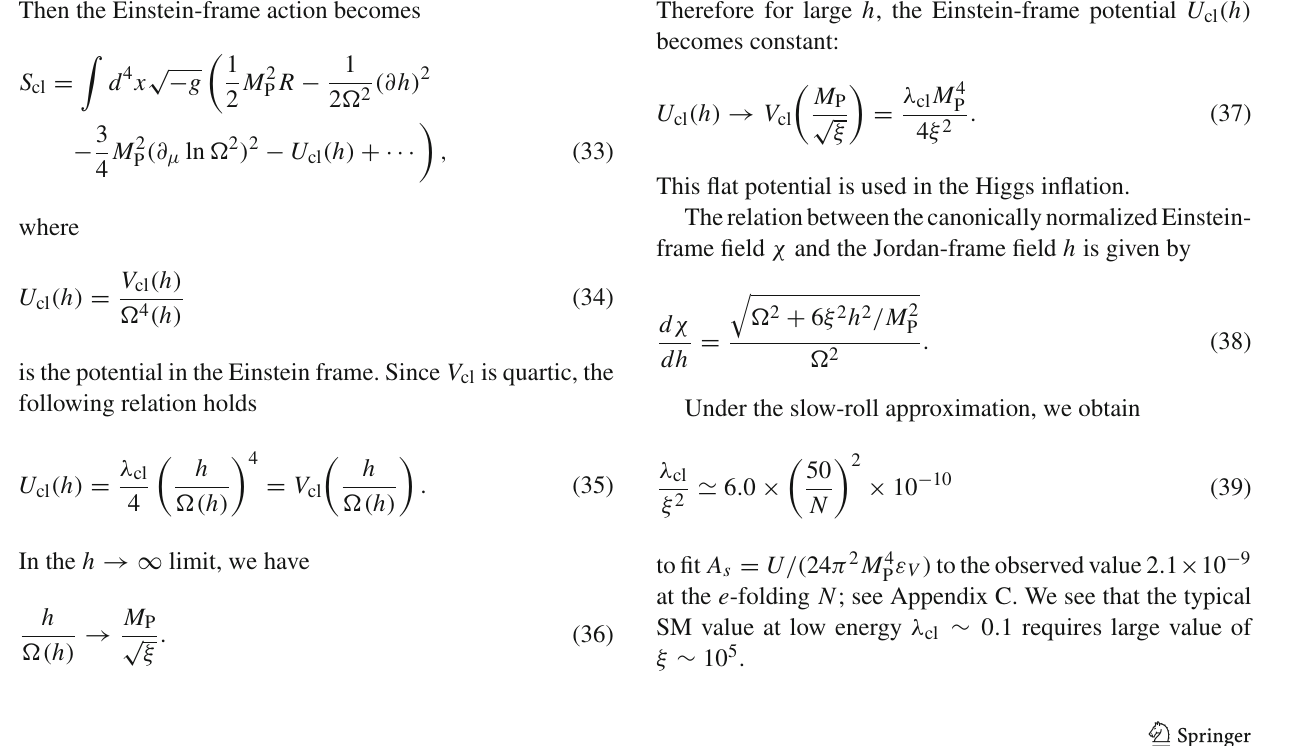
Fig. 4 UpperLeft:theone-loopeffectiveHiggspotentialinthenormal hierarchycasewherethedifferentcolorscorrespondtothedifferentval- uesof λ SH ( M t ) .Here,dashedblackcurvesrepresenttheHiggspotential whose quartic coupling is replaced by the analytical one (28). Upper Right: the relation between M R and λ SH ( M t ) determined by the saddle